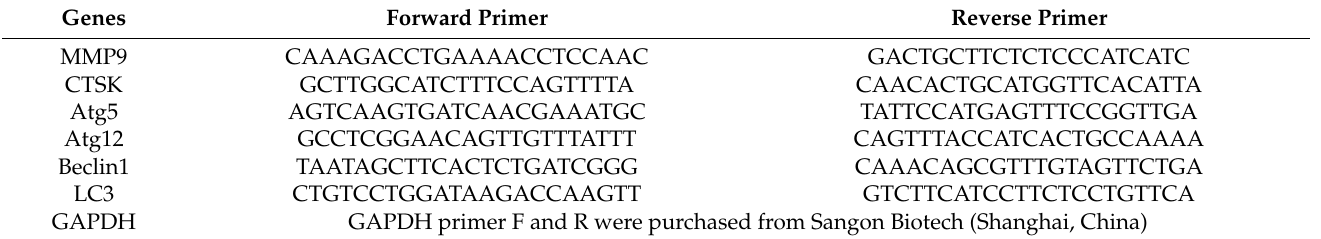
Table 1. Sequences of quantitative PCR